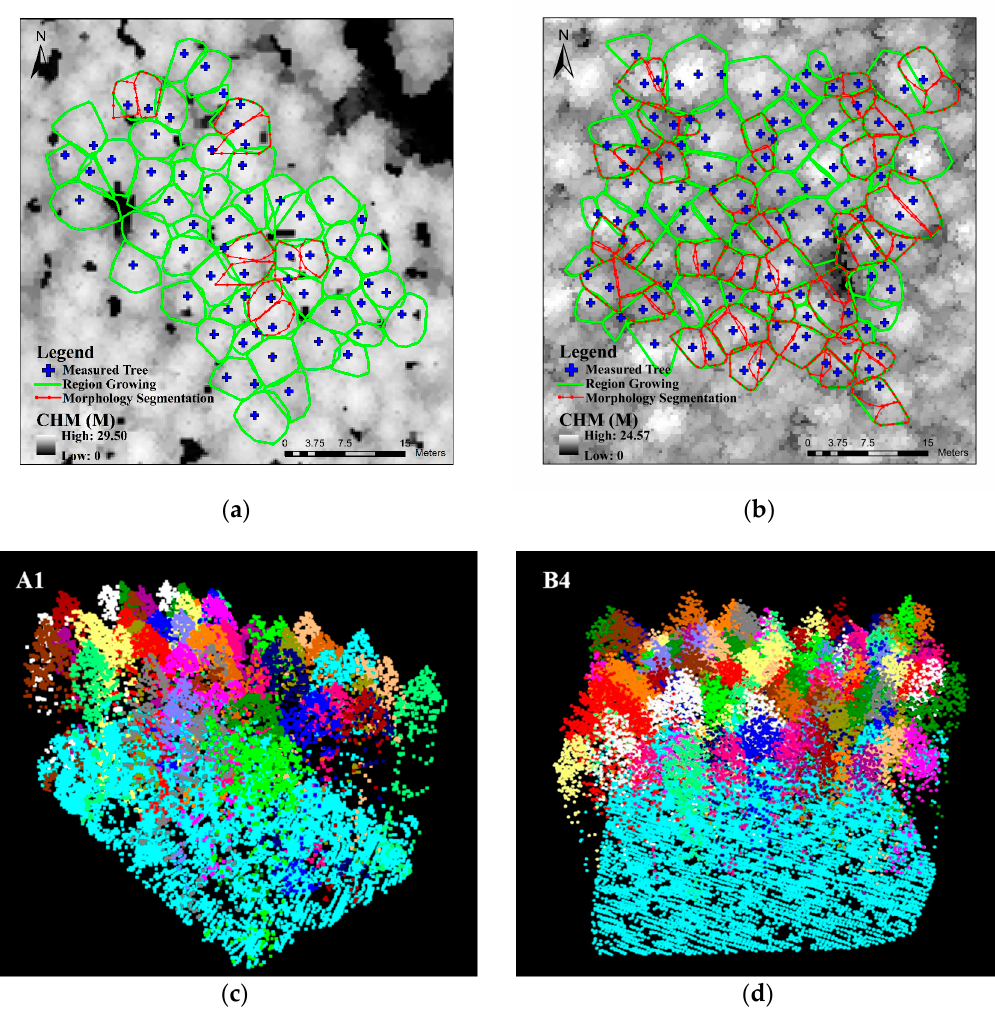
Figure 9. Tree segments of plot A1 ( a , c ) and B4 ( b , d ) generated using the region growing algorithm and morphology segmentation. In (a) and (b), a blue cross represents a measured single-wood position; a green boundary corresponds to a convex hull edge of a single tree derived from the region growing algorithm’s result; and a red boundary corresponds to tree segments that needed further refinement using morphology segmentation, where morphology segmentation successfully detected more than two trees in the region growing segments. Figures (c) and (d) show the segmented point cloud, where the color of points indicates individual tree segments.